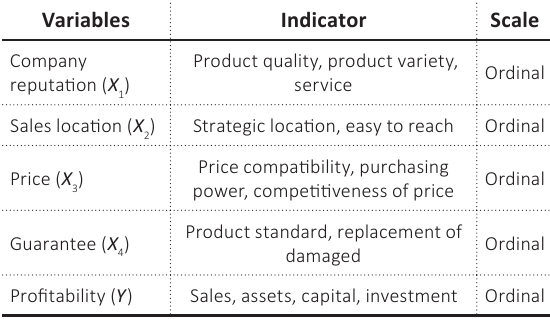
Table 1. Variable